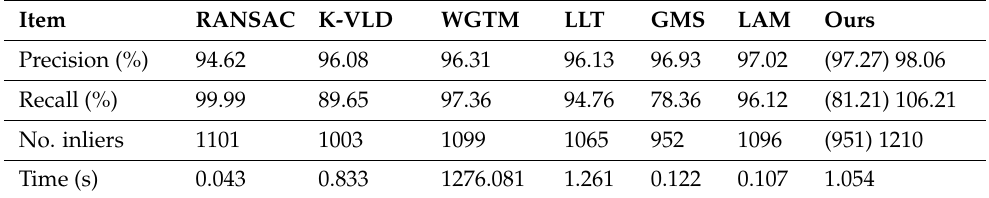
Table 1. Statistical results for the rigid dataset (value in the bracket indicates the statistical results without match expansion).